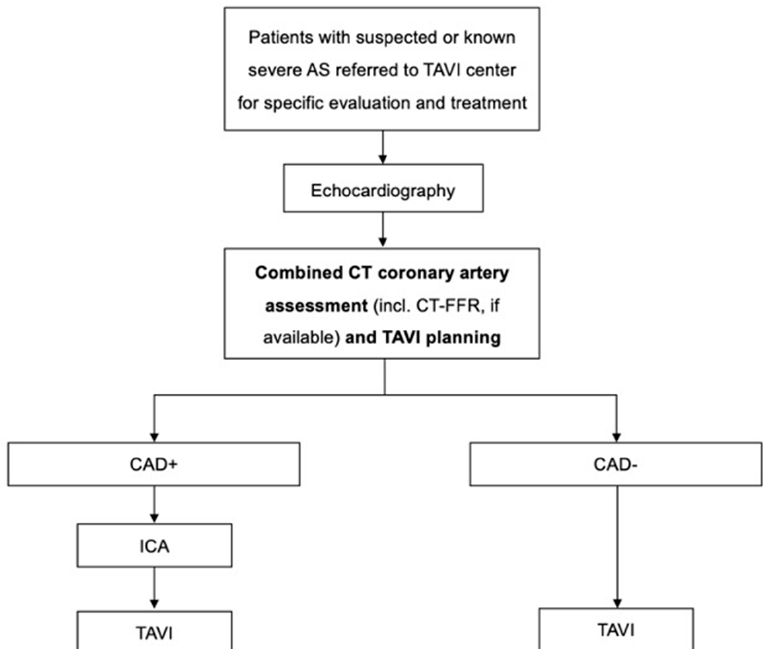
Figure 2. Proposed diagnostic algorithm of combined CT coronary artery assessment and TAVI planning. Abbreviations: CAD+ = suspicion of relevant coronary artery disease based on computed tomography; CAD − = relevant coronary artery disease ruled-out by computed tomography; CT–FFR = fractional flow reserve from computed tomography angiography; ICA = invasive coronary angiography; TAVI = transcatheter aortic valve